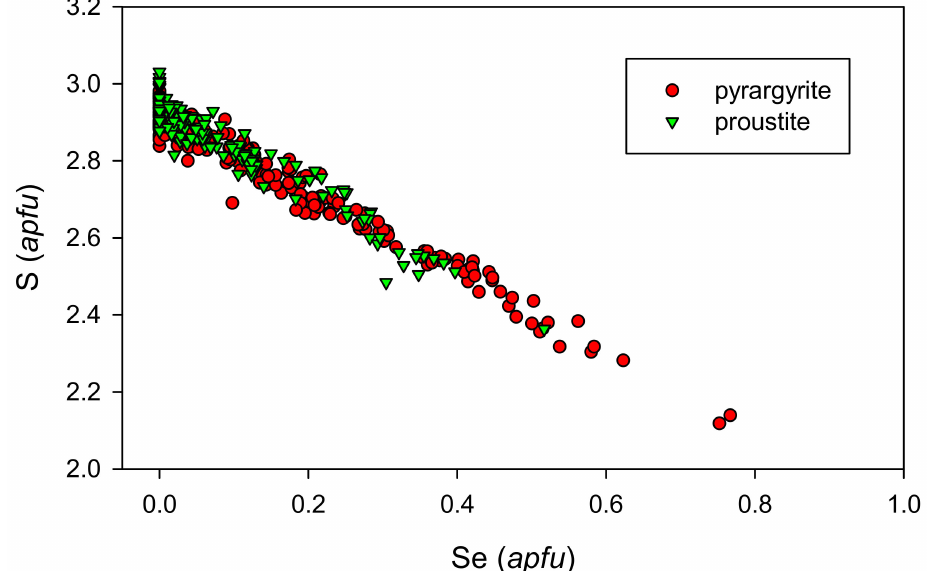
Figure 12. Graph of Se vs. S ( apfu ) for minerals of the pyrargyrite–proustite solid solution series from the Kremnica